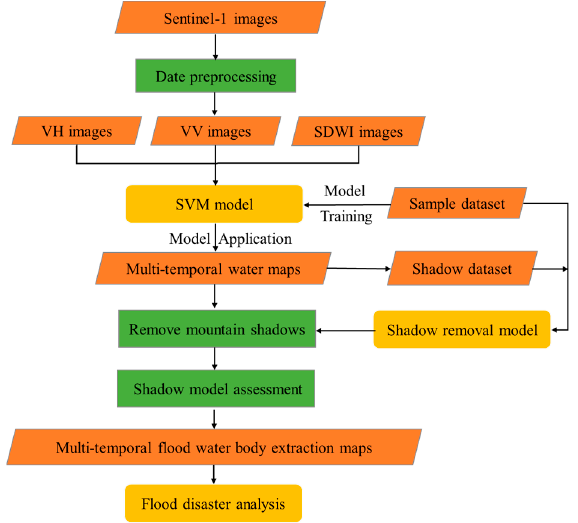
Figure 3. The flowchart of this